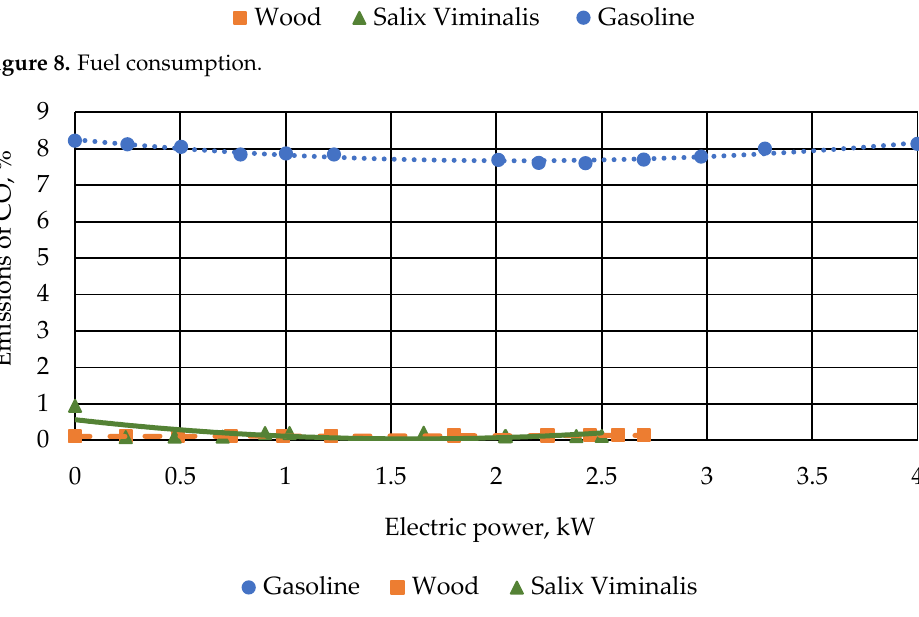
Figure 9. Emissions of CO.